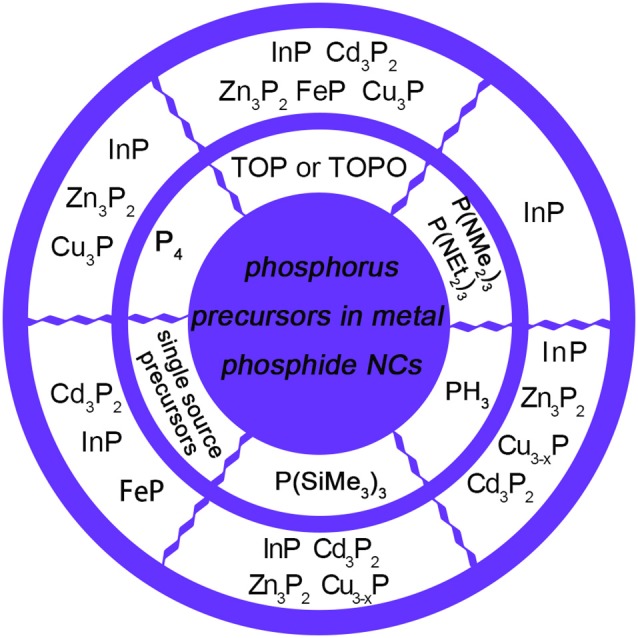
Various types of phosphorus precursors used in the synthesis of metal phosphide NCs. InP NCs could be synthesized by TOP (Lauth et al., 2013), P(NMe2)3 (Song et al., 2013), P(NEt2)3 (Tessier et al., 2015), PH3 (Li et al., 2008), P(SiMe3)3 (Micic et al., 1994), P4 (Ung et al., 2008), and single source precursors, including In(PBu2t)3 (Green and O'Brien, 1998) and magic-size clusters (MSCs) (Gary et al., 2015). Zn3P2 NCs could be synthesized by TOP (Mobarok et al., 2014), PH3 (Miao et al., 2013), P(SiMe3)3 (Ho et al., 2015), and P4 (Carenco et al., 2010). Cd3P2 NCs could be synthesized by TOP (Khanna et al., 2010), PH3 (Miao et al., 2012), P(SiMe3)3 (Miao et al., 2010), and MSCs (Li et al., 2014) acting as single source precursors. FeP could be synthesized by TOP (Henkes and Schaak, 2007) and (CO)4Fe(PH3) (Hunger et al., 2013) acting as single source precursors. Copper phosphides could be synthesized by TOP (Henkes and Schaak, 2007), PH3 (Manna et al., 2013), P(SiMe3)3 (Liu et al., 2016), and P4 (Bichat et al., 2004a).